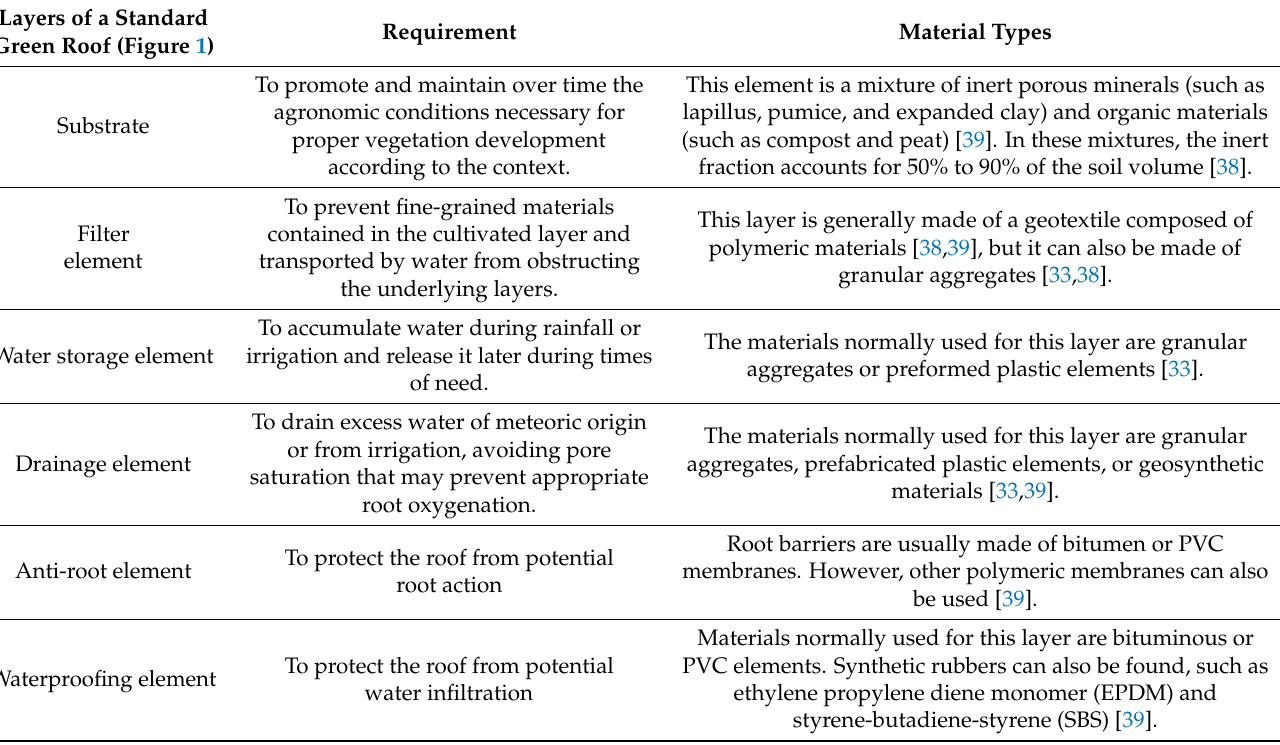
Table 1. Requirement and commonly used materials for the single layers of a standard green